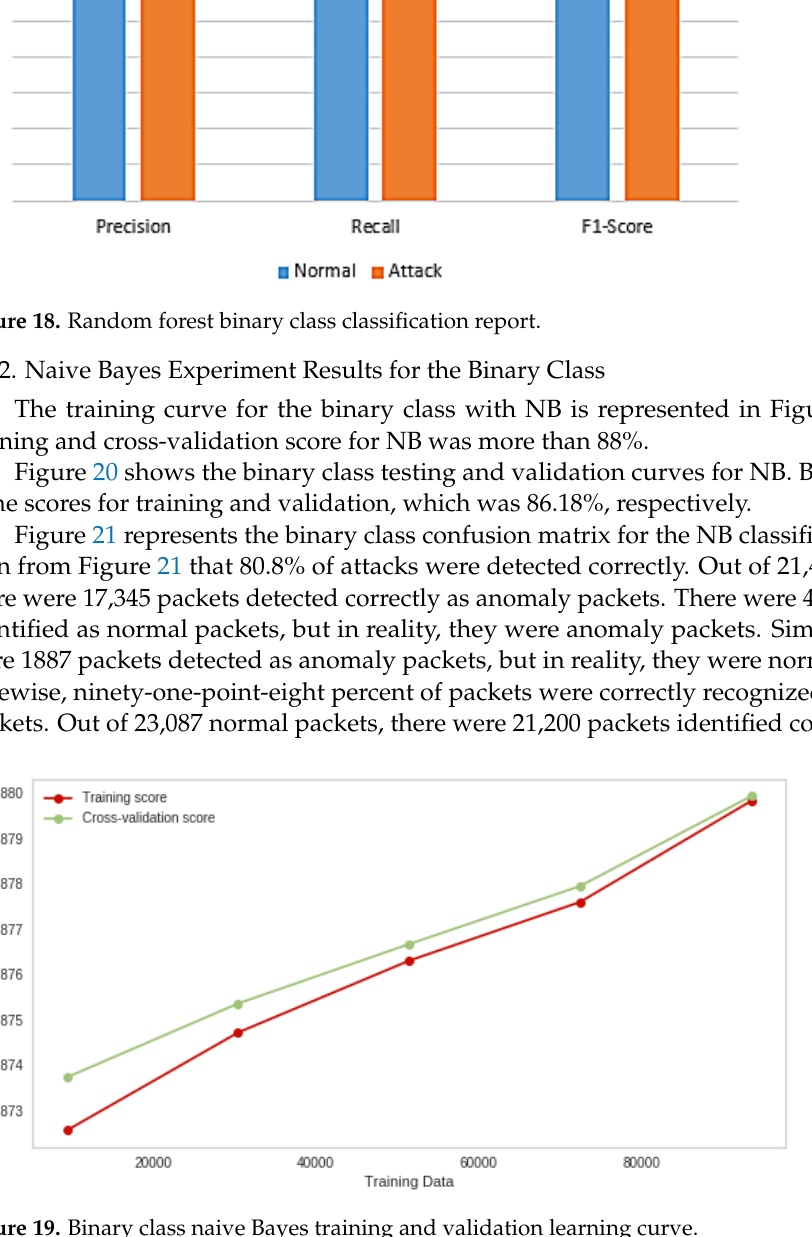
Figure 19. Binary class naive Bayes training and validation learning